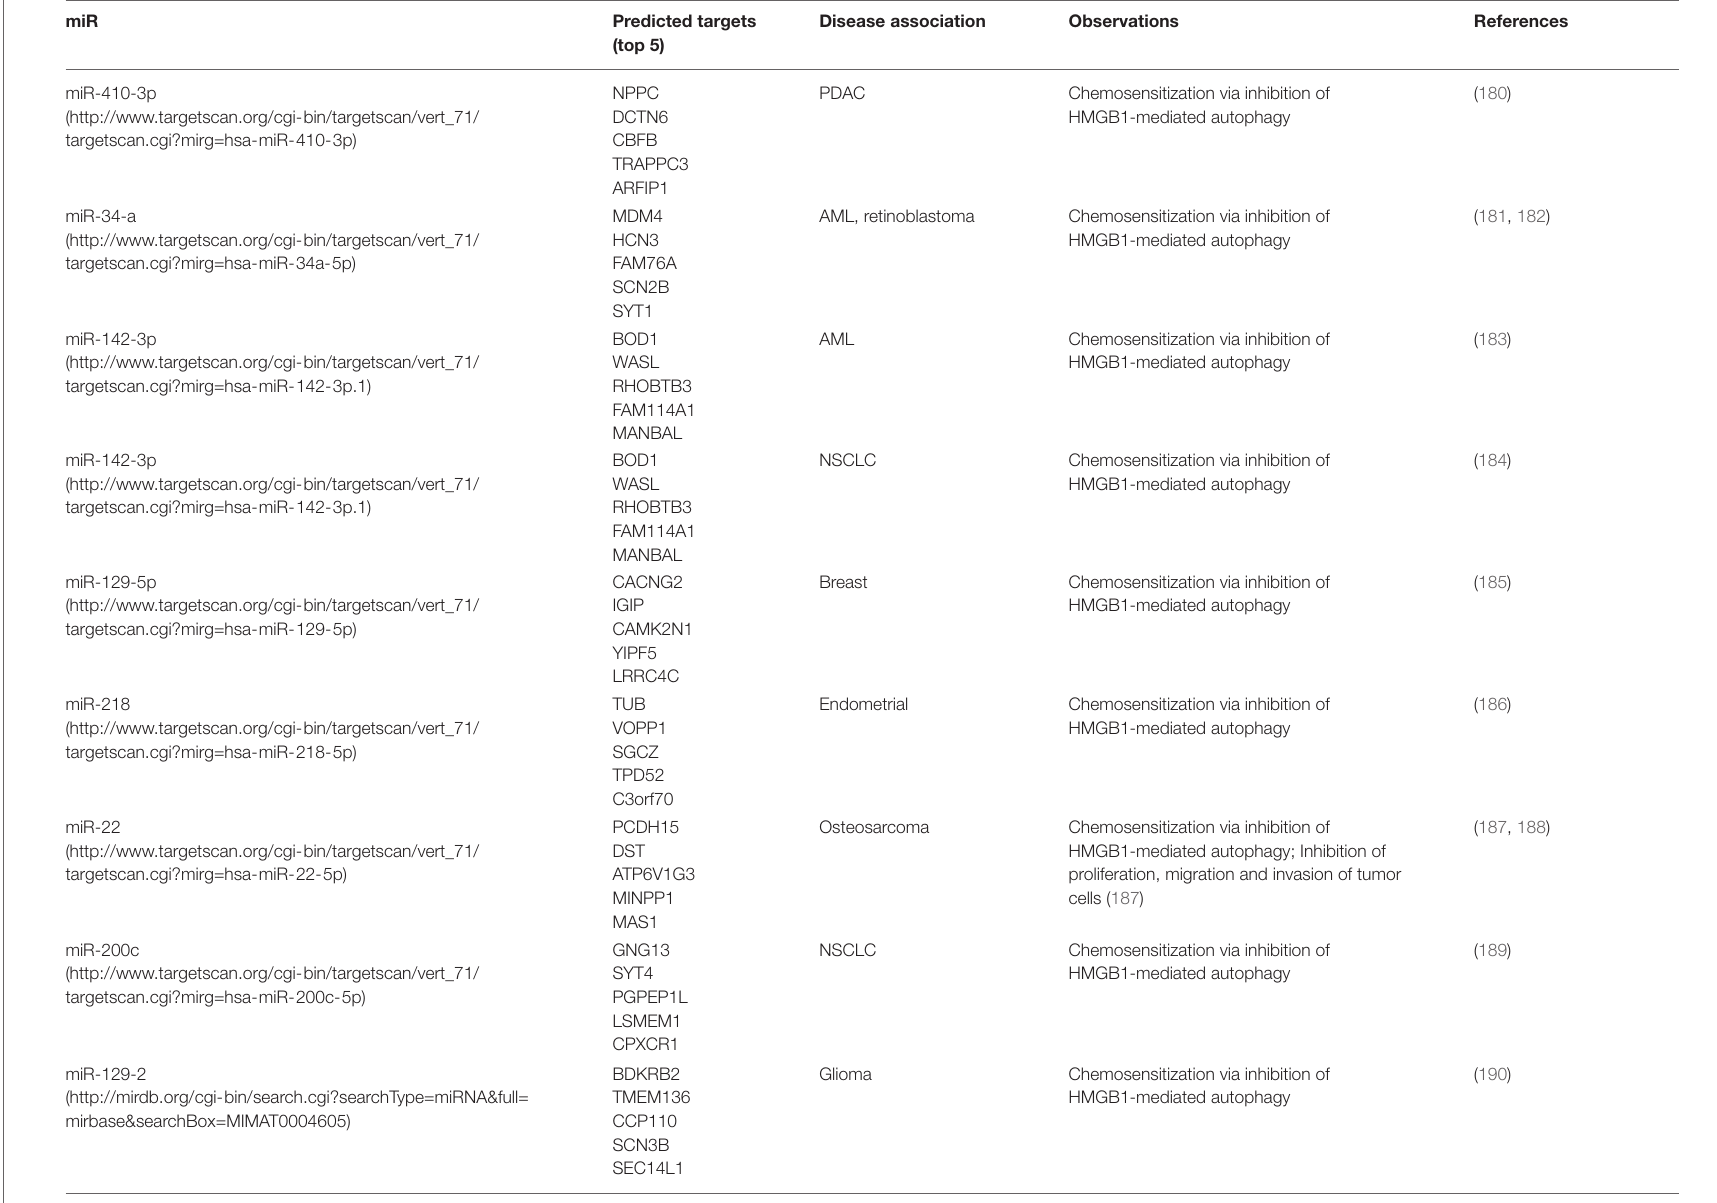
TABLE 2 | HMGB1-mediated autophagy is controlled by microRNAs.